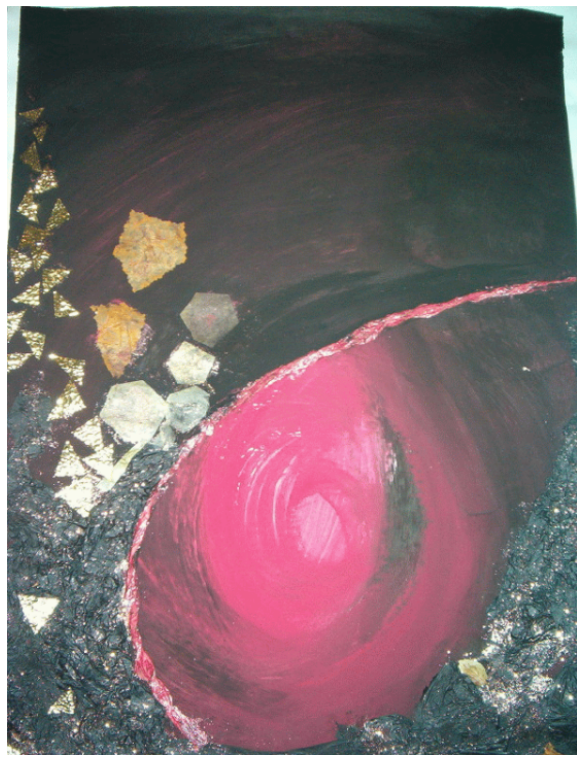
FFigigururee 55 “Pink Gold” in tempera paints, tissue paper and mixed